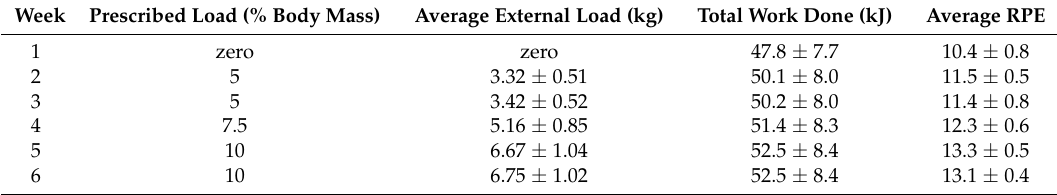
Table 1. Progressive training model, including relative prescribed external loads across the six-week programme and the average absolute external load for each